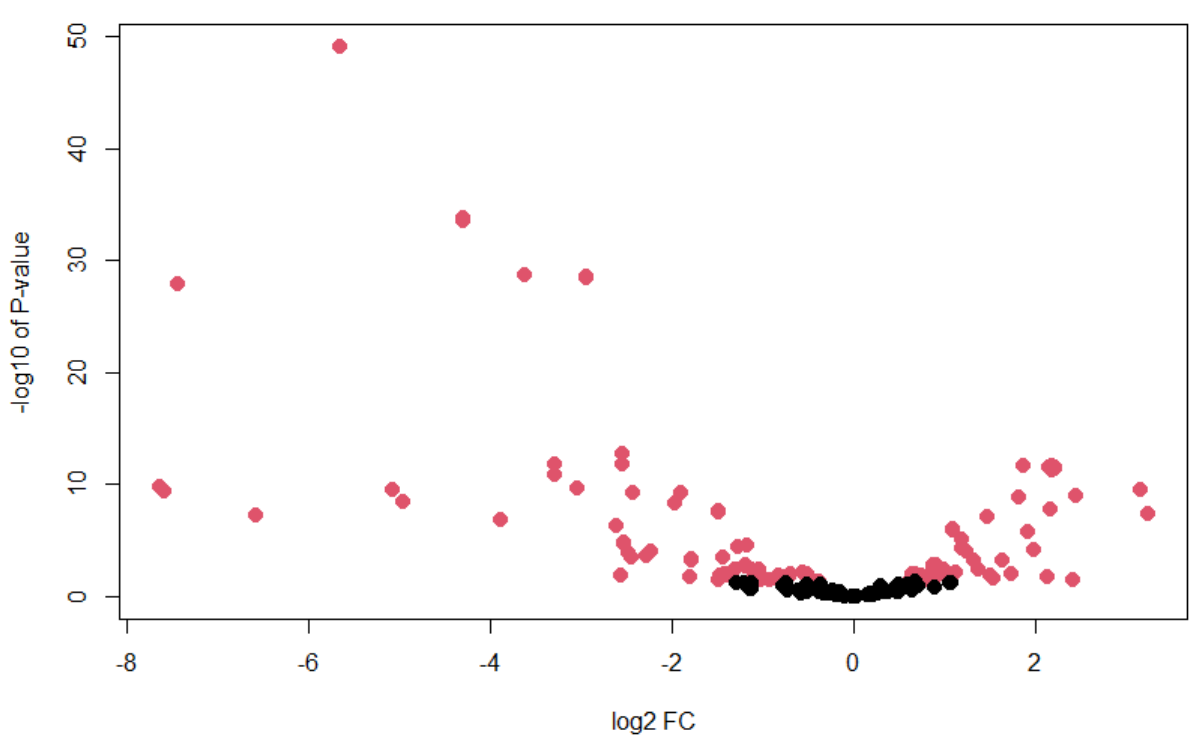
Figure 4. Volcano plot of differentially expressed miRNAs upon DENV1 infection. Each dot represents miRNAs (novel and known) with their corresponding log2 fold change and -log10 p -value. Red dots represent significant p -value (<0.05), while black dots represent insignificant p -value (>0.05). Avila-Bonilla et al., 2017 performed a small RNA-sequencing of C6/36 cells that were